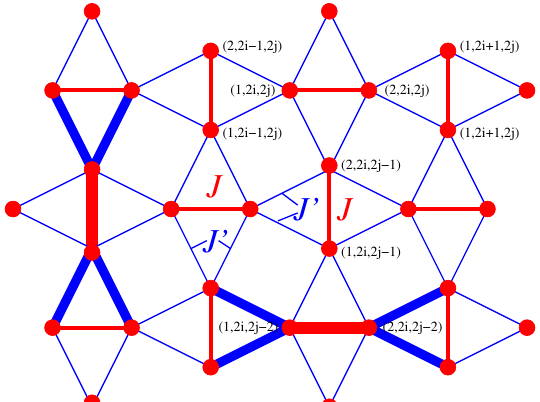
Figure 2: A schematic representation of the Shastry-Sutherland model defined through the Hamiltonian (1). Thick (red) lines denote the stronger intradimer cou- pling J , while thin (blue) lines show the interdimer coupling J (cid:48) . Bold lines mark clusters of three subsequent strongly correlated dimers in the Ising-Heisenberg model given by the Hamiltonian